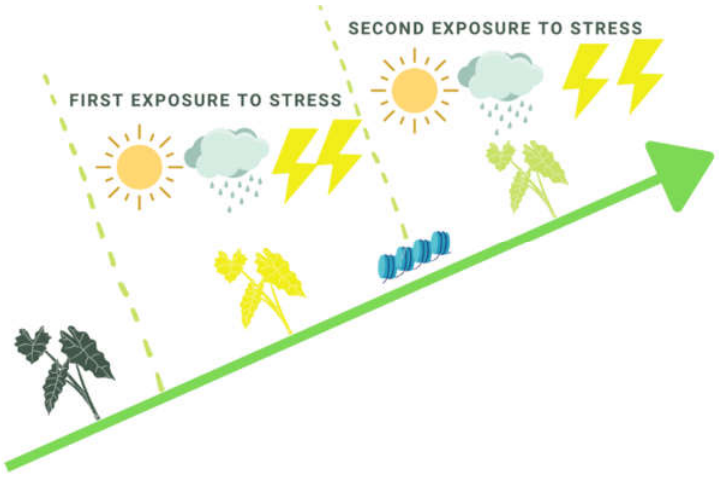
Figure 1. A model of plant memory acquirement due to consequential exposure to environmental stresses.